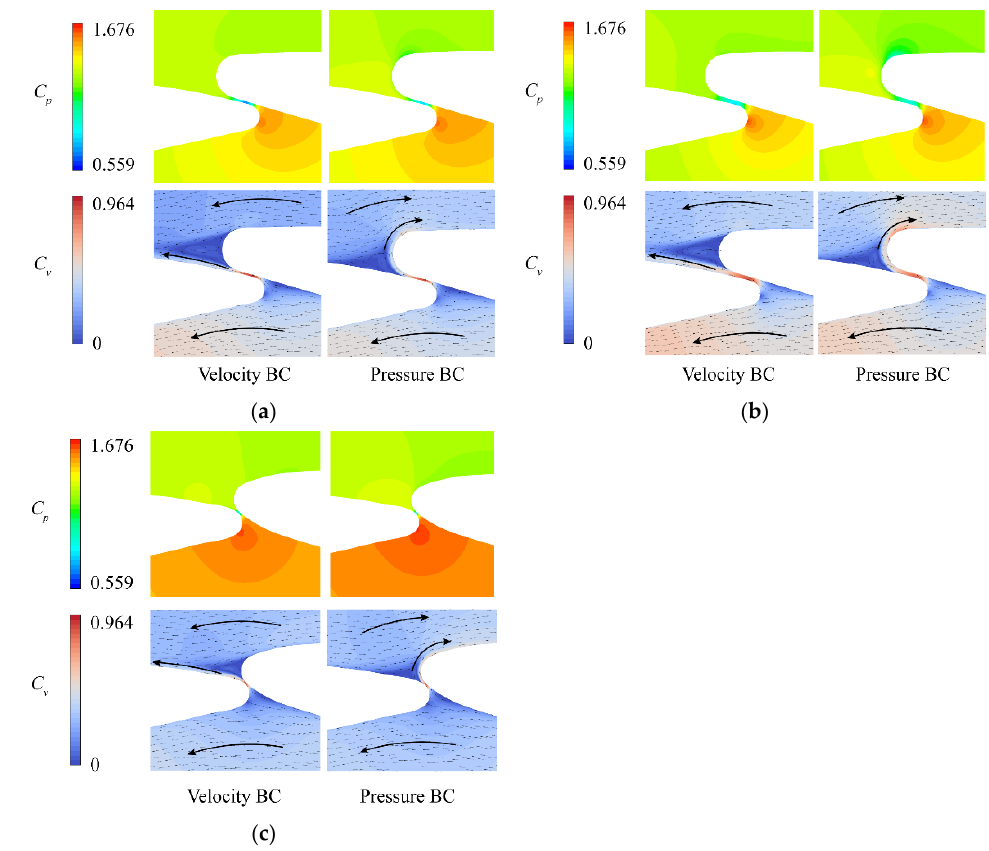
Figure 16. Contours of C p and contours of C v with vectors at the example condition of C ψ = 1.133 under different inlet boundary conditions. ( a ) α = 0.2° for GV-O; ( b ) α = 0.4° for GV-O; ( c ) α = 0.2° for GV-M.